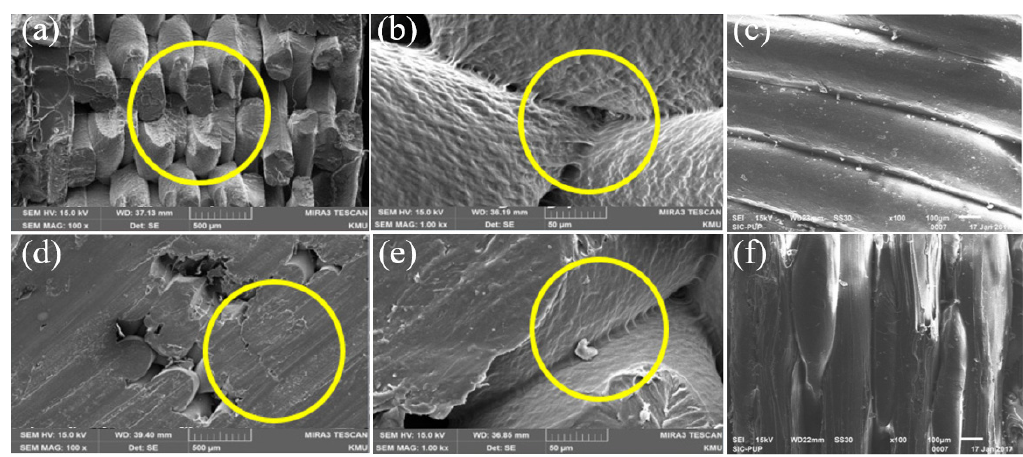
Figure 20. ( a ) Fracture surface of the untreated PLA specimen. ( b ) Bond between PLA filaments of the untreated specimen. ( d ) Fracture surface of the annealed PLA specimen. ( e ) Bond between PLA filaments of the annealed specimen. ( c ) Surface of the untreated ABS specimen. ( f ) Surface of the annealed ABS specimen. Heat treated specimens increased their layer and raster adhesion. ( a ), ( b ), ( d ), ( e ): [243], ( c ), ( f ): [242].